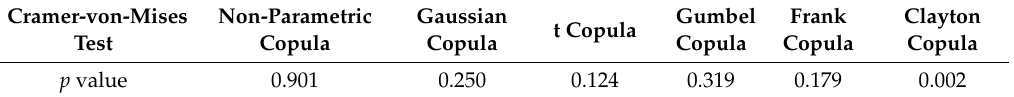
Table 1. The p values of Cramer-von-Mises test between the observation data and various Copula models. Cramer-von-Mises Non-Parametric Gaussian Gumbel Frank Clayton t Copula Test Copula Copula Copula Copula Copula p value